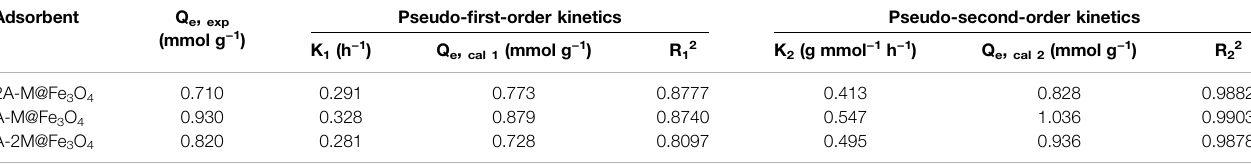
TABLE 5 | The adsorption kinetics parameters of bifunctional PSQ/CNTs magnetic composites for Hg(II) at 25 ° C. Adsorbent Pseudo- fi rst-order kinetics